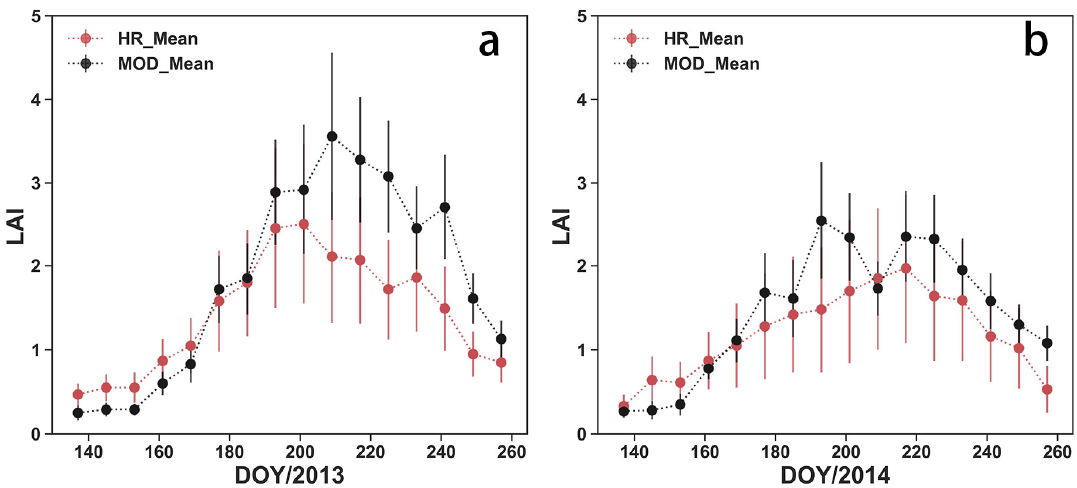
Figure 10. Time series comparison between the mean of the LAI at Huailai and the corresponding LAI of the MODIS product: ( a ) 2013, ( b ) 2014. The error bars represent the standard deviation from the MODIS LAI product (black) and the retrieved LAI (red).